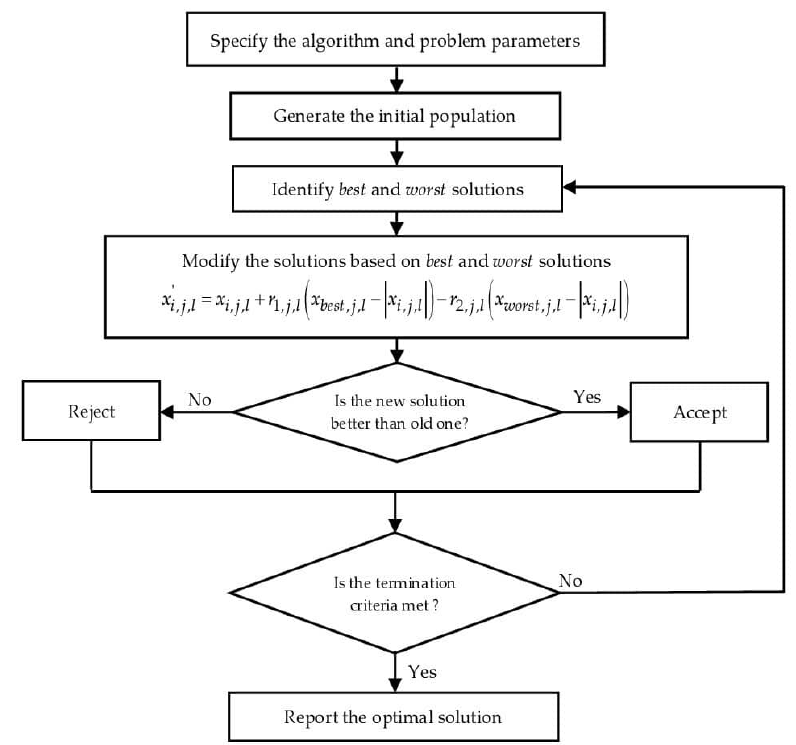
Figure 1. Flowchart of Jaya algorithm.